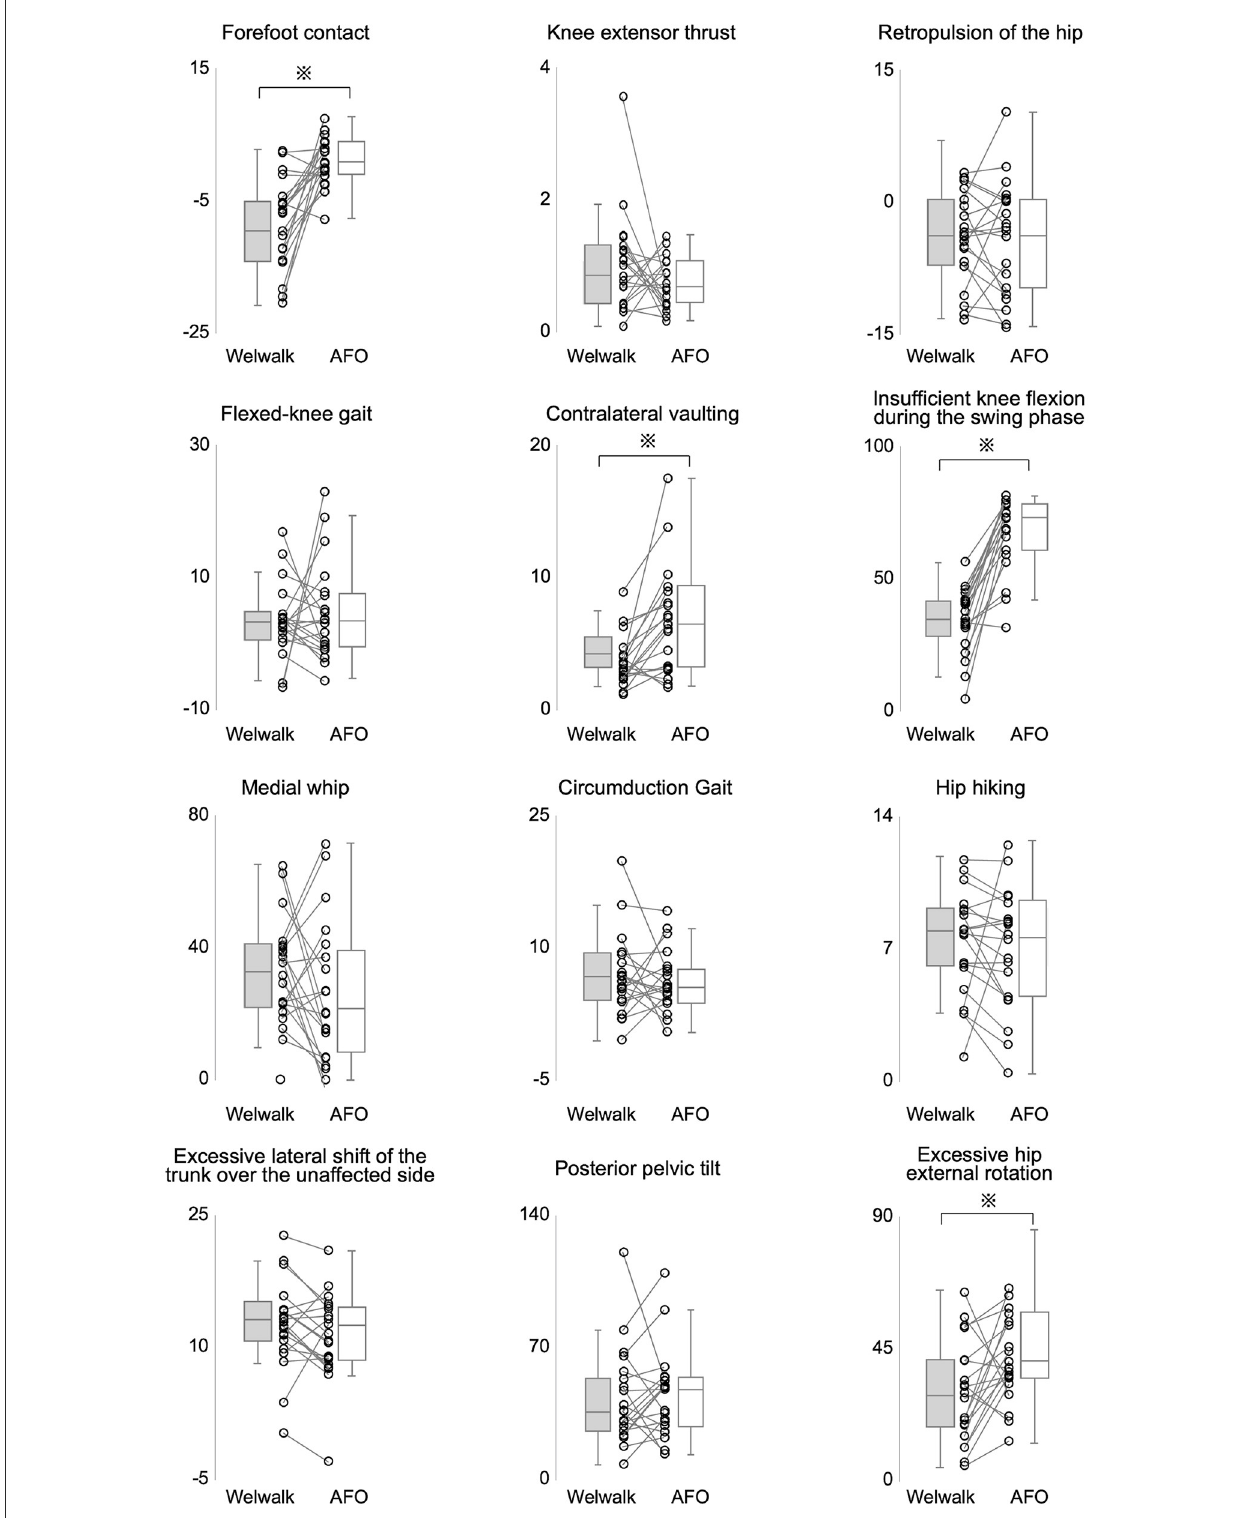
FIGURE2 Comparison of the severities of abnormal gait patterns. A comparison of index values representing the severity of abnormal gait patterns between the Welwalk and the orthosis conditions is shown. The vertical axis represents the index values. All index values were compared using the Wilcoxon-signed rank test. * P -values < 0.05 were considered statistically